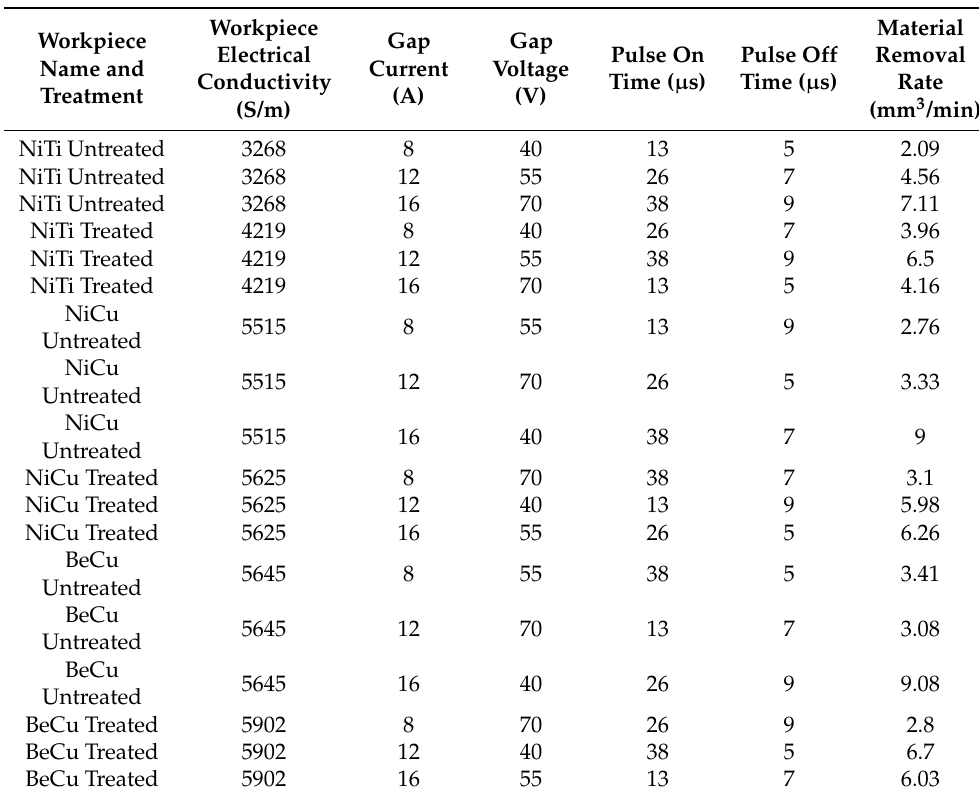
Table 2. Experimental Layout with trial conditions and observed